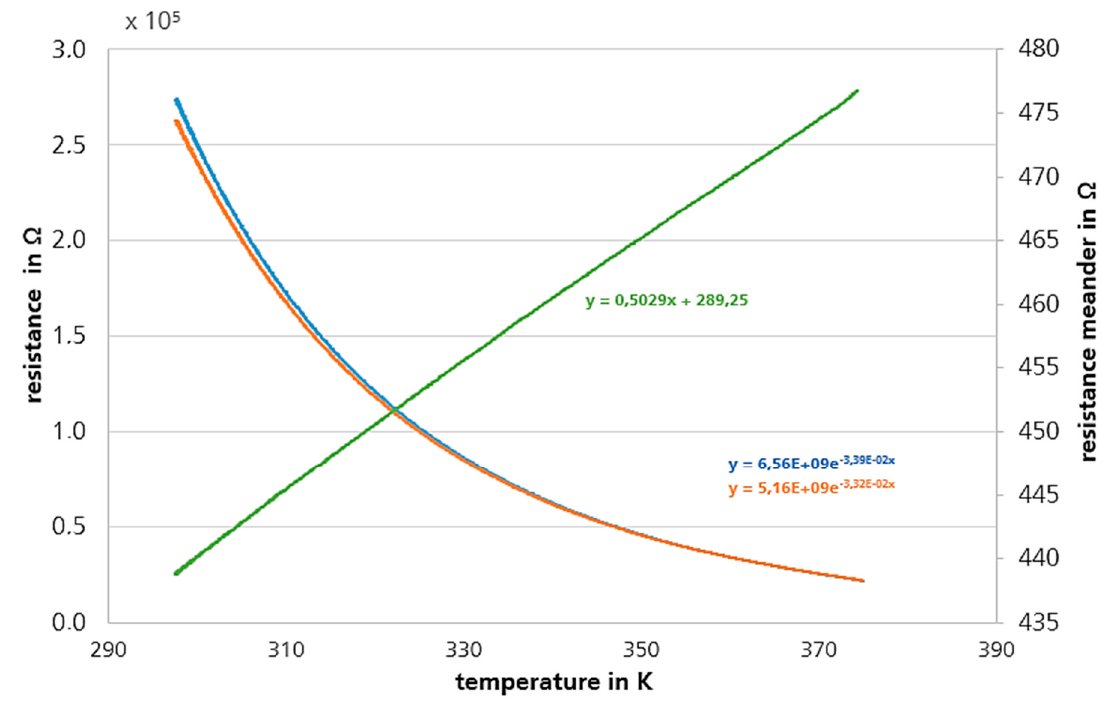
Figure 3. Characteristic resistance dependencies of the three sensor structures.